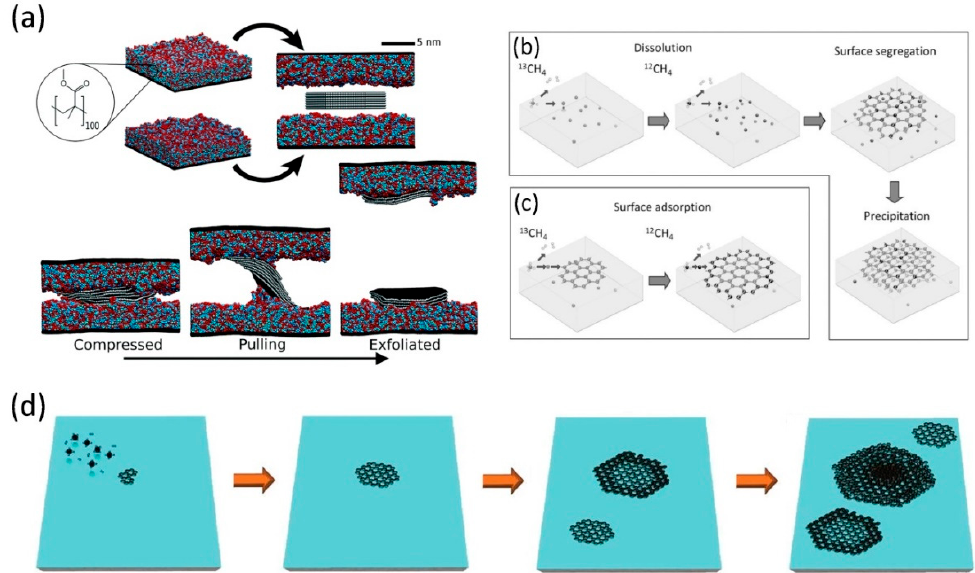
Figure 2. ( a ) Schematic diagram of direct exfoliation to obtain graphene by a top-down method. Reproduced from [49] with the permission from Royal Society of Chemistry. Mechanistic diagrams for the growth of graphene films by surface segregation ( b ) and surface adsorption ( c ). Reproduced from [58] with the permission from Wiley Online Library. ( d ) Schematic representation of the growth process of graphene on silicon substrate using atmospheric pressure chemical vapor deposition (APCVD). Reproduced from [59] with the permission from Open Access Science Online.